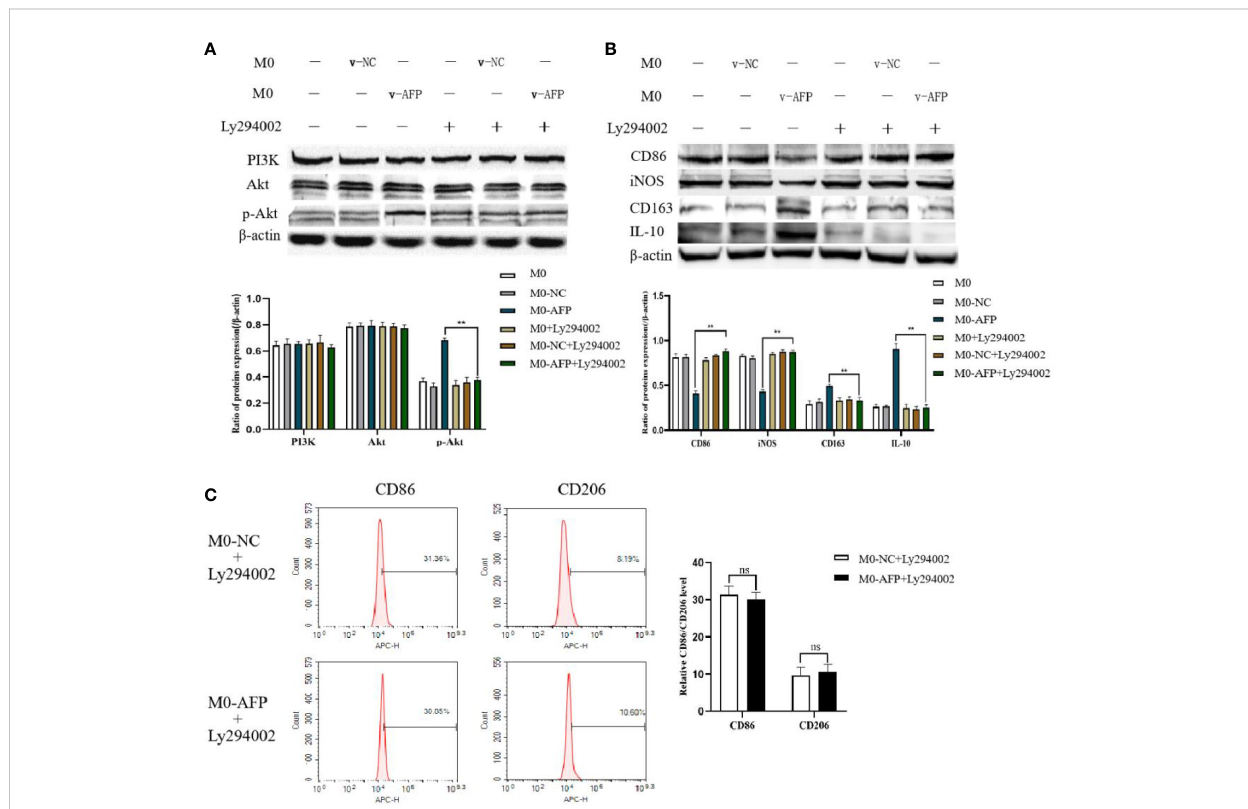
FIGURE 3 The effects of AFP and the PI3K inhibitor Ly294002 on the expression of M1- and M2-type macrophages ’ markers. The M0 macrophages were infected with AFP-expressing negative control lentivirus vectors (M0-NC) or AFP-expressing lentivirus vectors (M0-AFP) for 48 h and then treated with LPS+IFN- g or IL-4+IL-13 for 24 h, followed by treated with Ly294002 ( fi nal concentration: 20 m mol/L) for 24 h. (A) The expression of PI3K, Akt and p-Akt(Ser473) proteins in the M0-NC and M0-AFP groups was analyzed by Western blotting; the right column diagram displays the expression levels of proteins in each group statistically analyzed by gray scanning, ** P <0.01; (B) The expression of the M1-type macrophage markers CD86 and iNOS and the M2-type macrophage markers CD163 and IL-10 in the M0-NC and M0-AFP groups analyzed by Western blotting; the right column diagram displays the expression levels of proteins in each group statistically analyzed by gray scanning, ** P <0.01. (C) The expression of the M1-type macrophage marker CD86 and the M2-type macrophage marker CD206 in macrophages of the M0-NC and M0-AFP groups was detected by fl ow cytometry; the right column diagram displays statistical analysis of the expression of CD86 and CD206 in each group (NS: P > 0.05). The results of the at least three independent experiments are shown. v-NC: negative control lentivirus vectors; v-AFP: AFP-expressing lentivirus